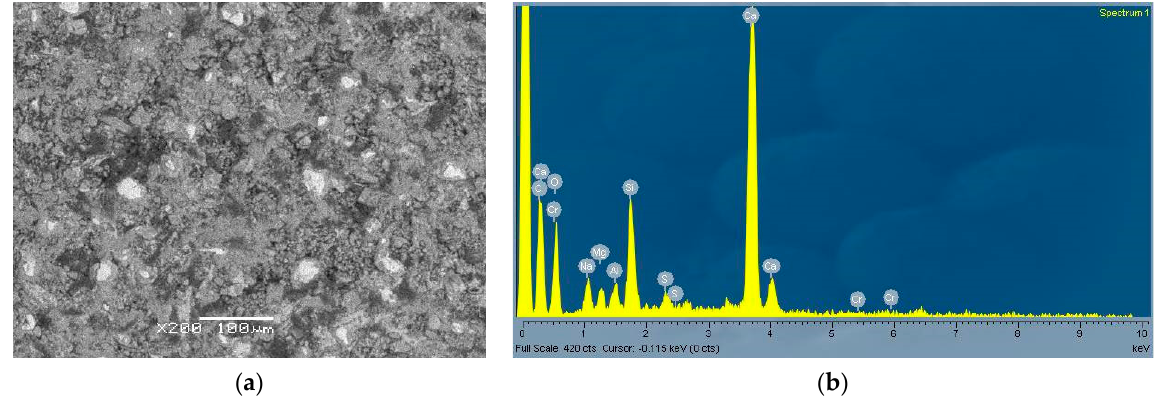
Figure 6. SEM image of CWA paste ( a ) with corresponding EDS ( b ).